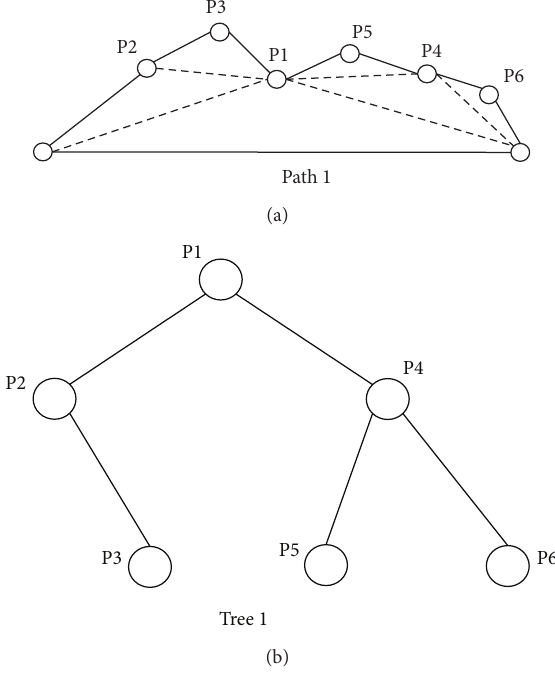
Figure 4: A path with 6 turning points and its corresponding binary